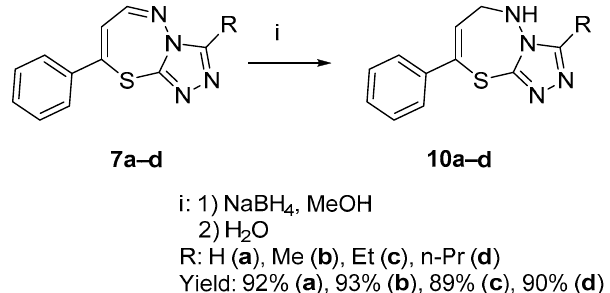
Figure 7. Proposed reaction mechanism for the formation of triazolothiadiazepines 7 .